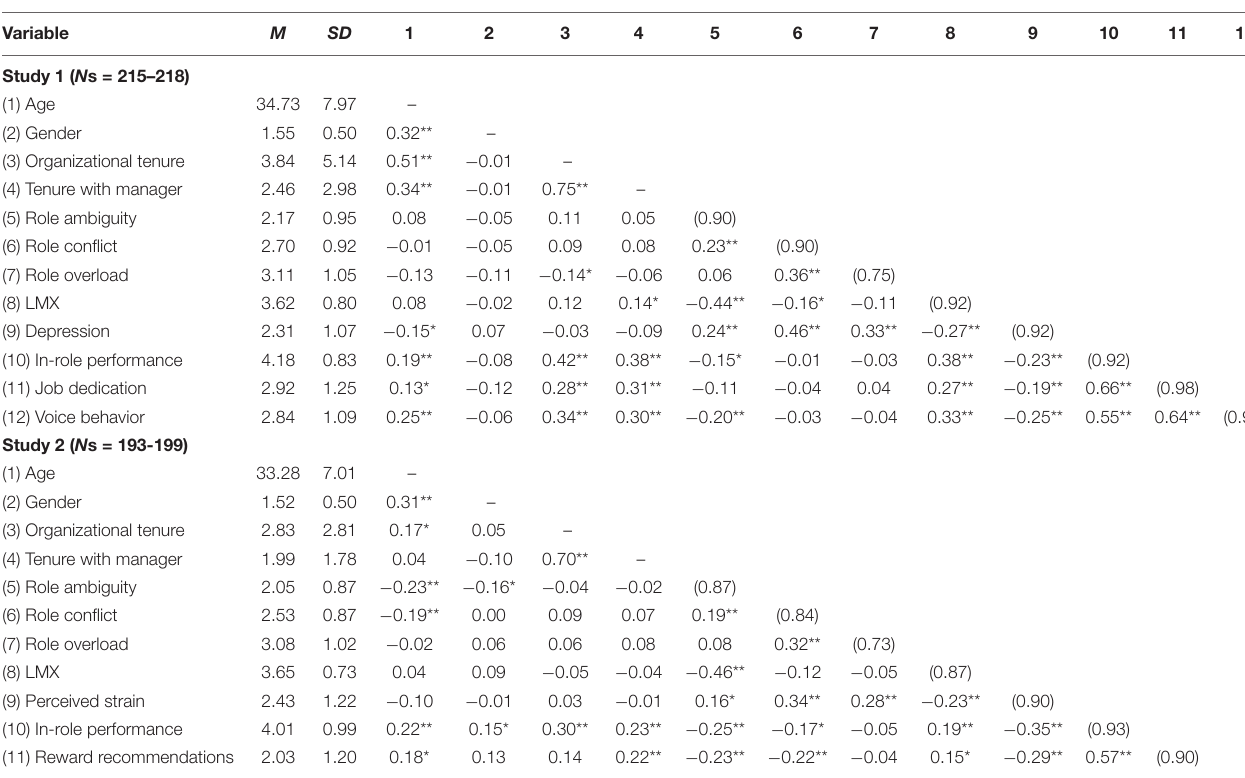
TABLE 2 | Study 1 and Study 2 Descriptive Statistics and